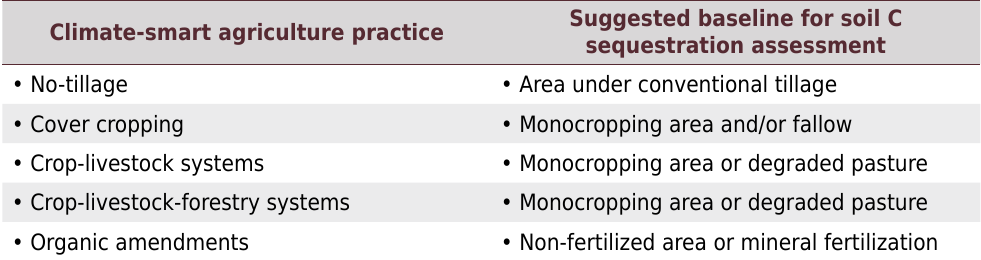
Suggested baseline for soil